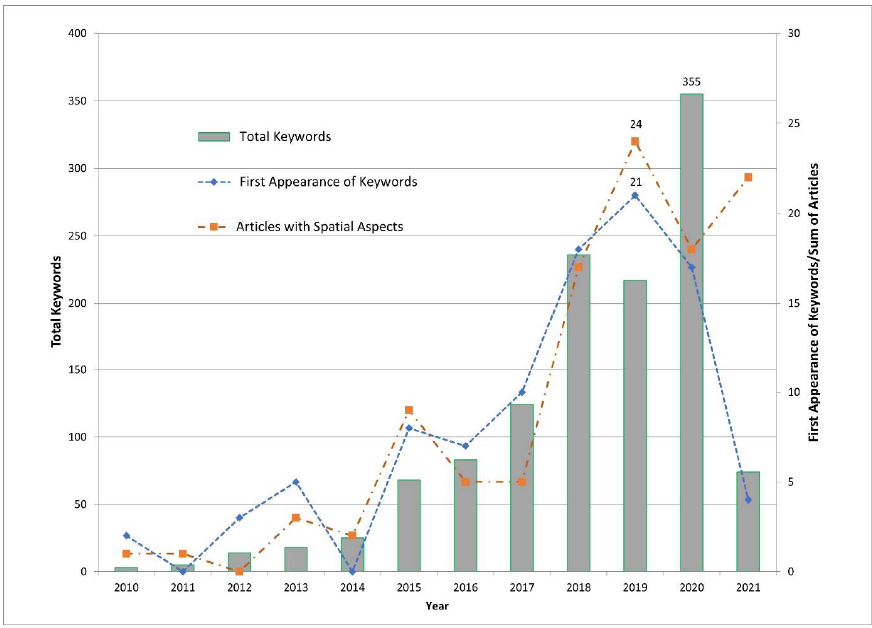
Figure 4. Comparison of first appearance of a keyword with the total number of articles and keywords per year.